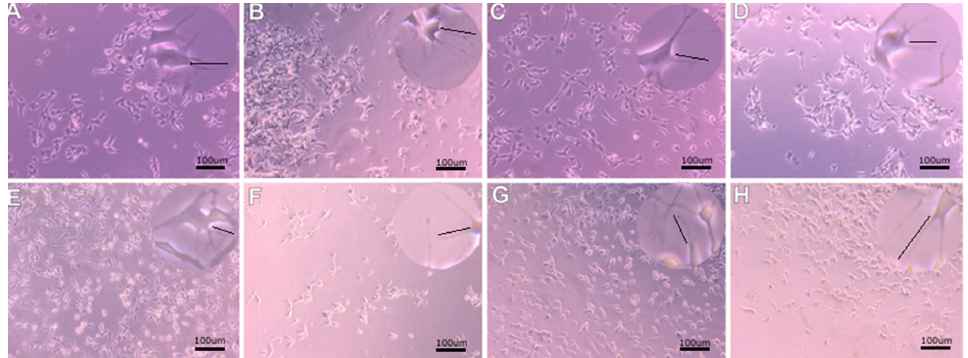
Figure 4. Vibration with a frequency of 100 Hz. ( A ) PM non-collagen—100 Hz, ( B ) PM non-collagen –control, ( C ) PM collagen—100 Hz, ( D ) PM collagen—control, ( E ) DM non-collagen—100 Hz, ( F ) DM non-collagen–control, ( G ) DM collagen—100 Hz, ( H ) DM collagen—control. In the upper right corner, zoom in to show neurites.